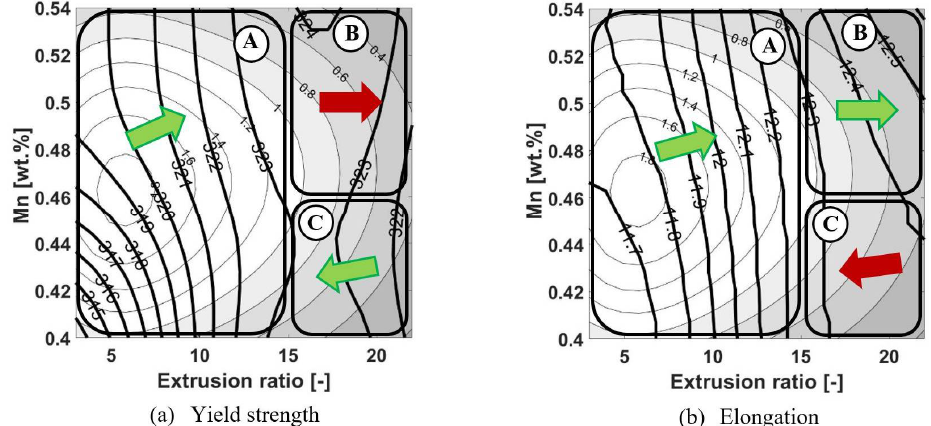
Figure 2. Common influence of extrusion ratio and Mn content on yield strength ( a ) and elongation ( b ). Green (grey) and red (dark) arrows indicate increase and decrease of the observed mechanical property.